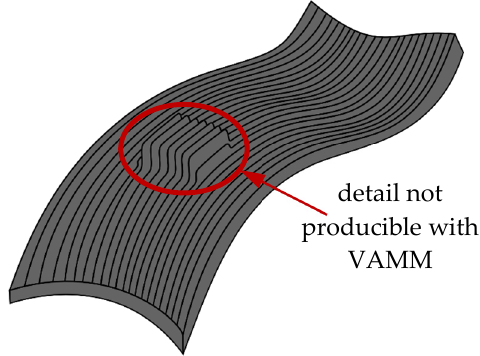
Figure 5. Schematic of a CFRP-part including a detail not producible with VAMM in the central part.